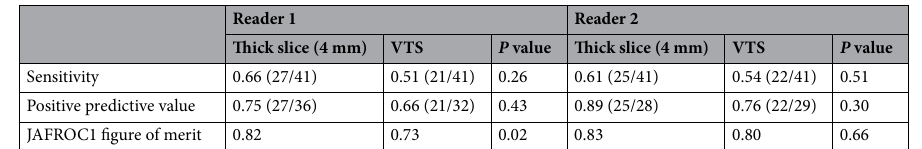
2 absolute percentage error between measured heights on VTS images and those on thin slice images.